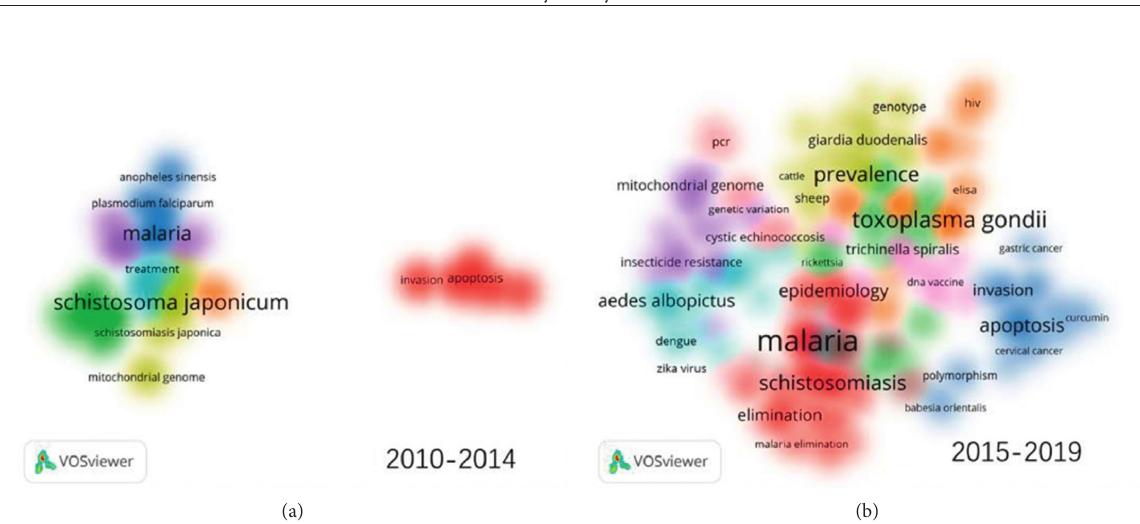
Figure 3: Mapping on cooccurrence of keywords used in Chinese tropical medicine articles. (a) Mapping on cooccurrence of keywords used in Chinese from 2010 to 2014. (b) Mapping on cooccurrence of keywords used in Chinese from 2015 to